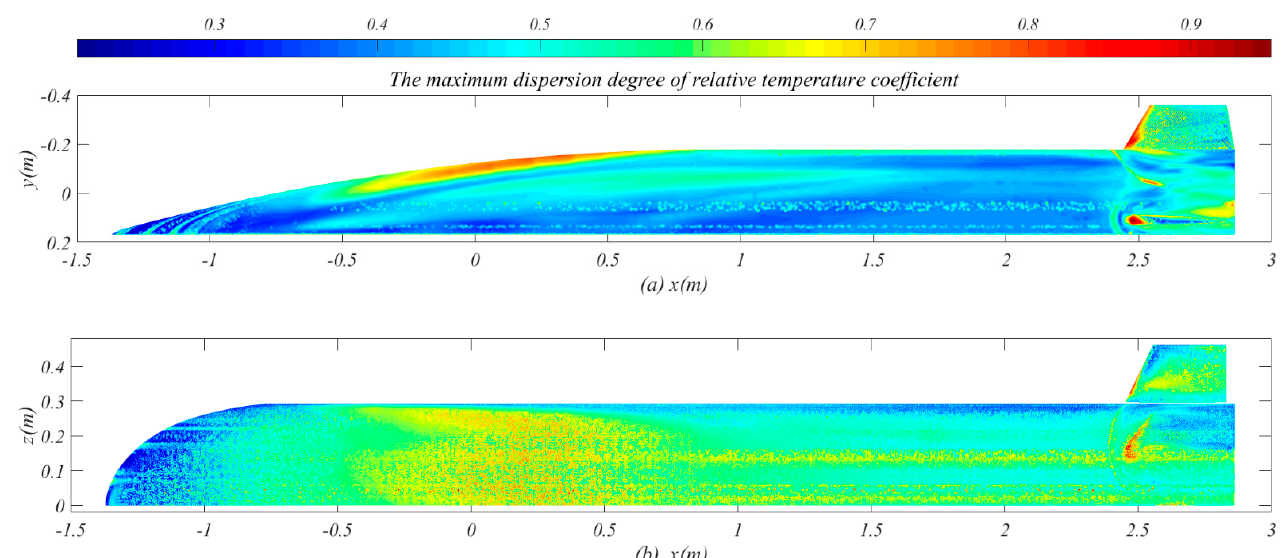
Figure 9. The maximum dispersion degree of relative temperature coefficient on leeward side considering all flight conditions: ( a ) the side view of aircraft; ( b ) the top view of aircraft